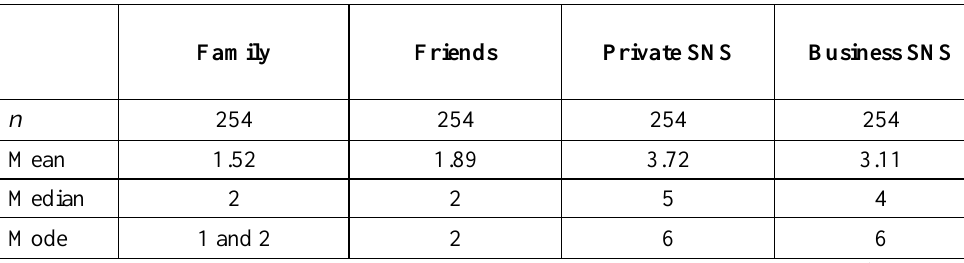
Table 1. Key Indicators of Central Tendency or Location on Respondent Evaluations of the Question “How important is it for you that other people are informed about your employment there?”